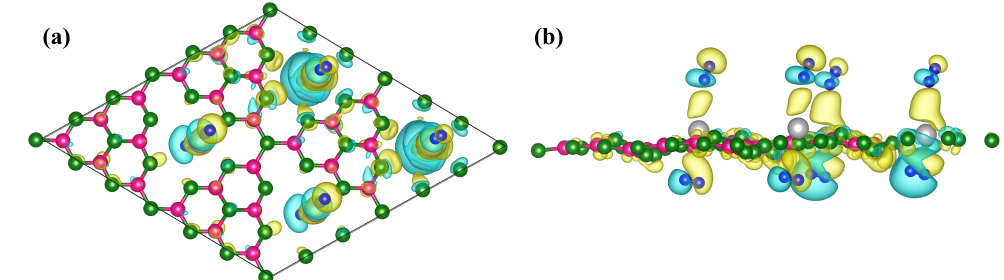
Figure 12. Charge density difference for the Al-decorated g-C molecules, ( a ) top and ( b ) side view. Yellow regions indicate charge gain and blue regions indi- cates charge loss. The isosurface of charge density isosurface is 0.06 e/Bohr 3